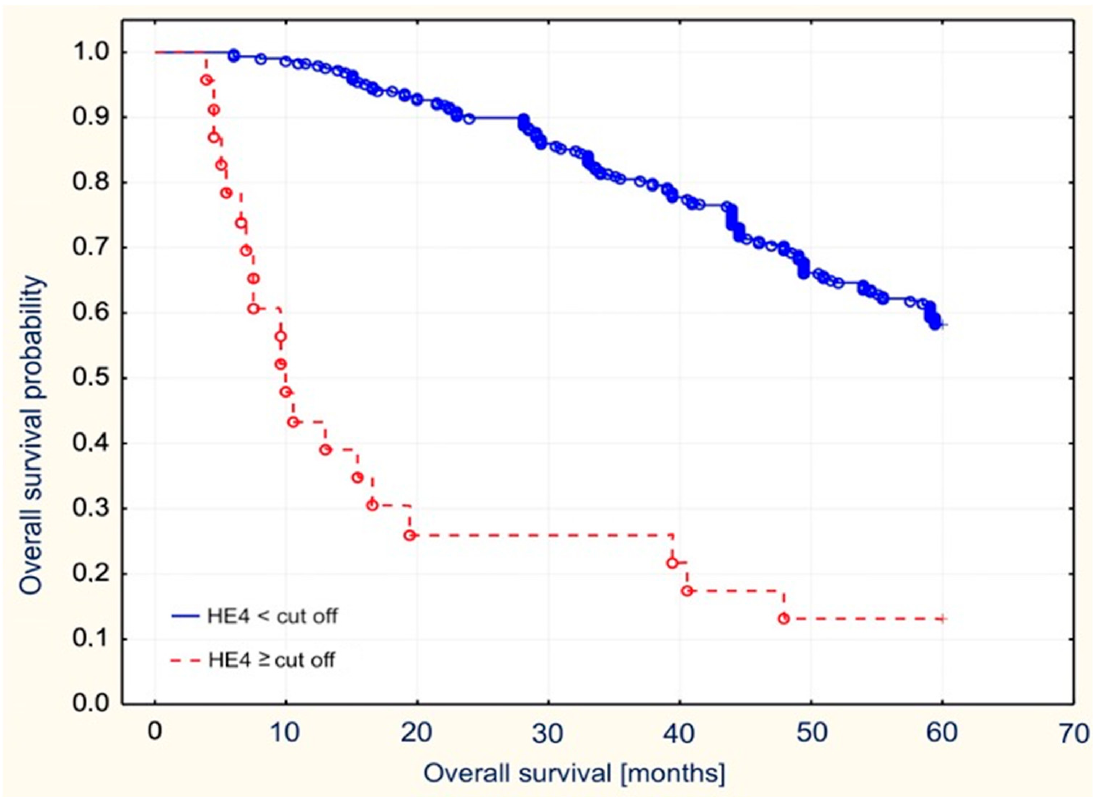
Figure 6. Overall survival stratified by median HE4 values in the examined patients with endometrial